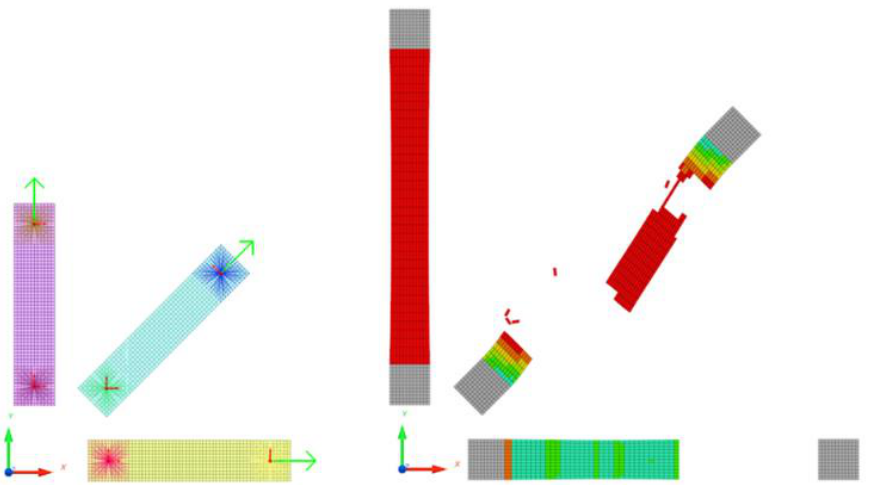
Table 3. Failure displacement results in test and simulation.